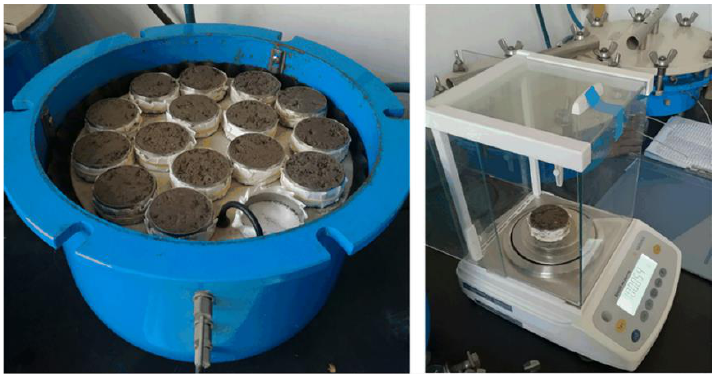
Figure 4. Test device for the pressure film meter method.